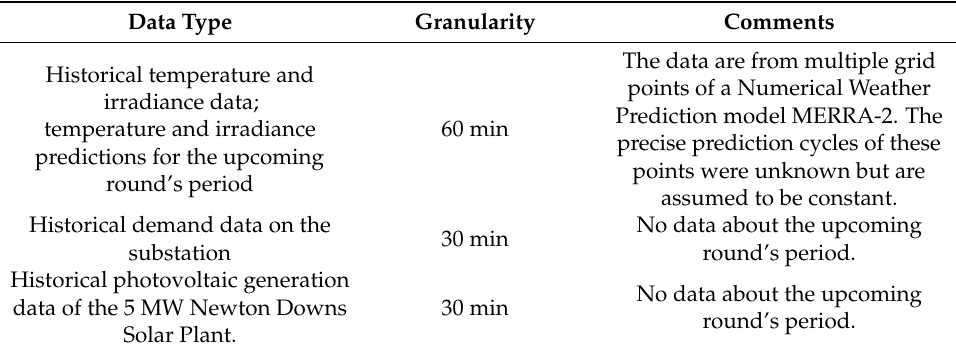
Table 3. Given data and their granularities, further